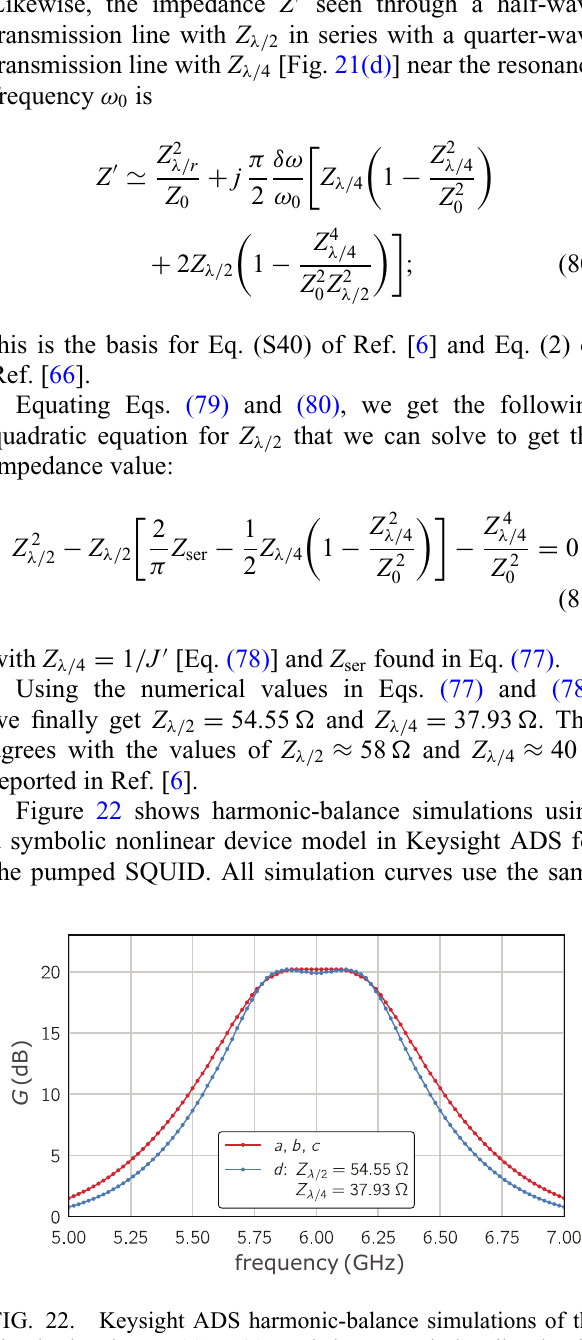
FIG. 22. Keysight ADS harmonic-balance simulations of the circuits in Figs. 21(a)–21(c), and the transmission line imple- mentations, Fig. 21(d), with the parameters indicated in the